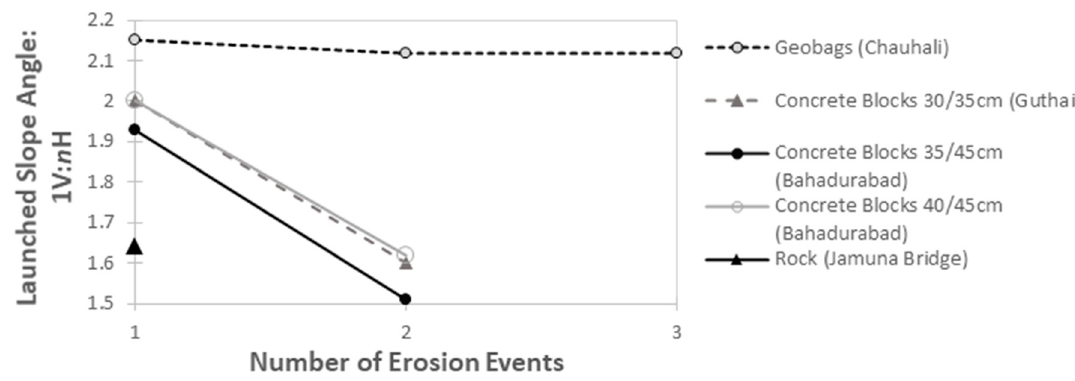
Figure 14. Slope angles of launched aprons after multiple attacks (data from Diggelmann [60] and recent investigations under FRERMIP [48]).